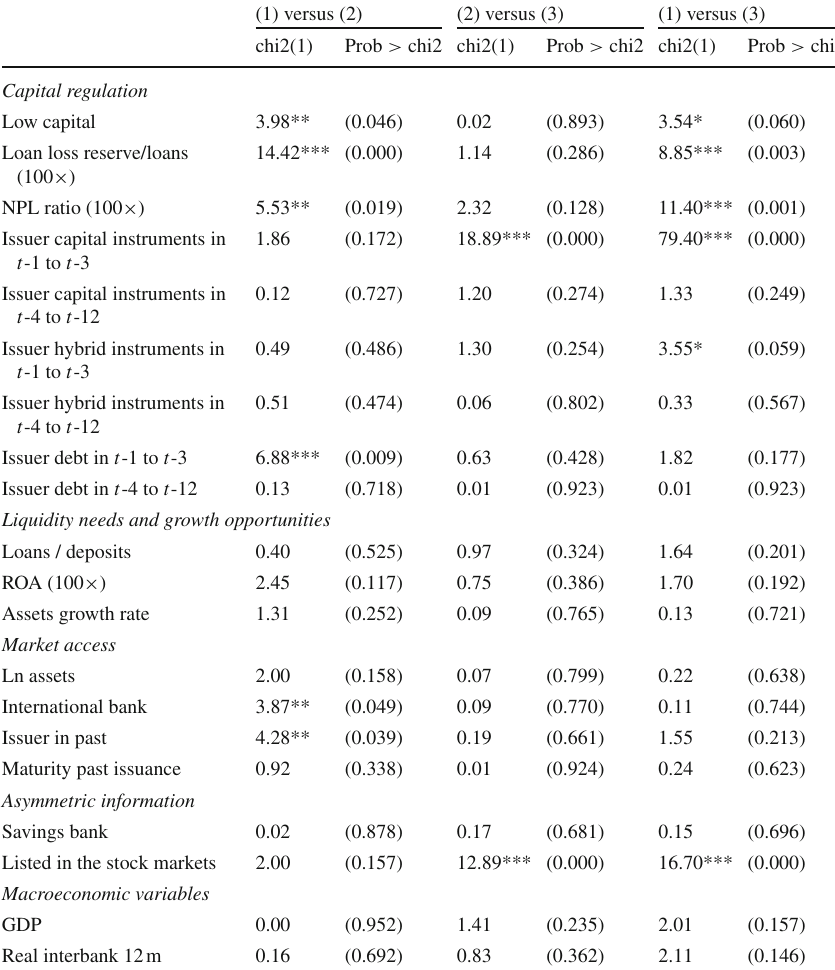
Table 4 Cross-tests of equality of coefficients between equations (1) versus